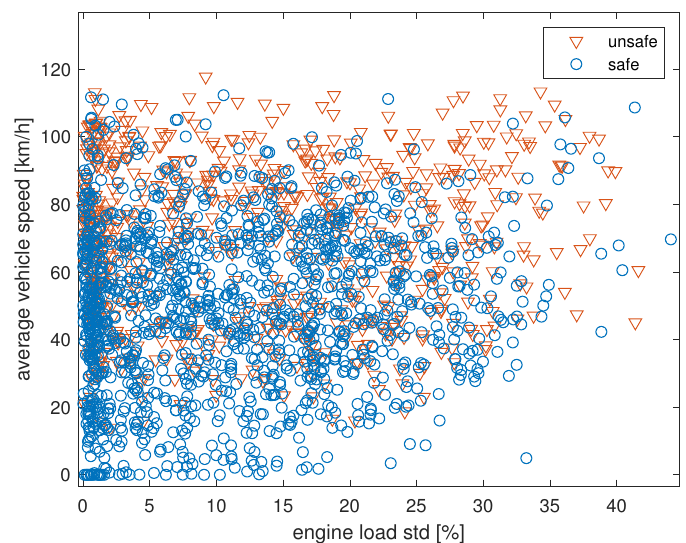
Figure 5. Scatter plot of the standard deviation of the engine load plotted versus the average vehicle speed.